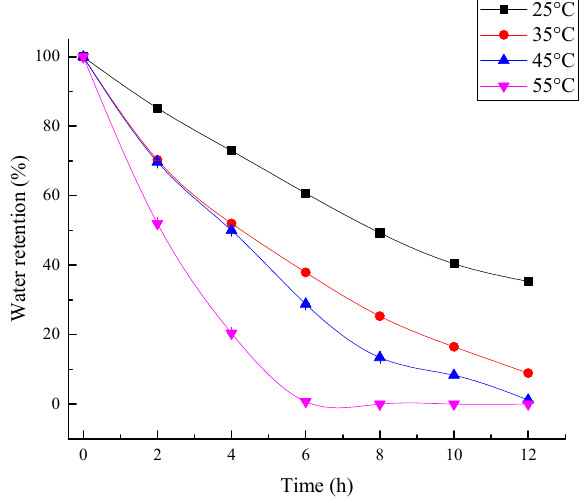
Figure 14. The influence of various temperatures on water retention of the composite.